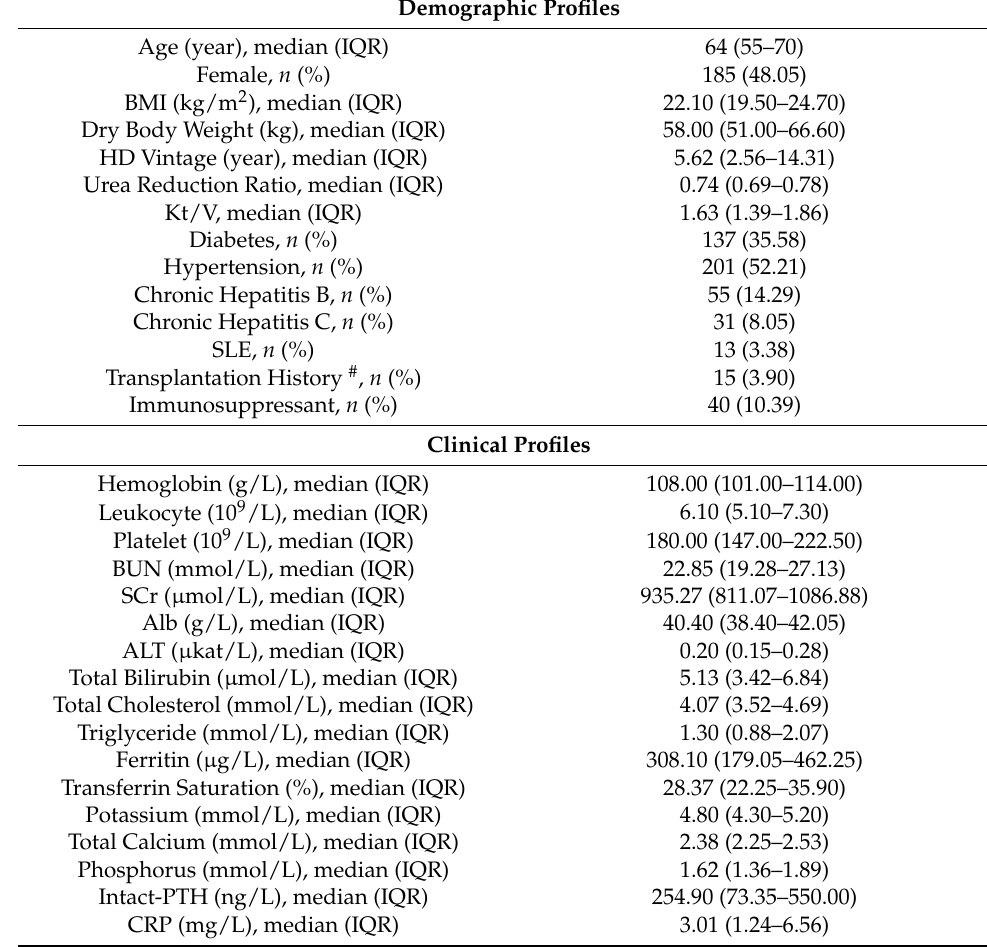
Table 1. Characteristics of HD Patients ( n = 385) Receiving ChAdOx1 nCoV-19